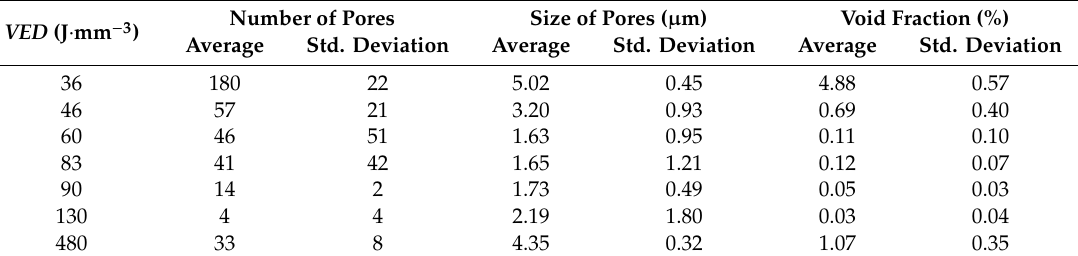
Average Std. Deviation Average Std. Deviation Average Std. Deviation